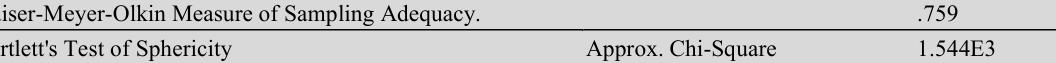
Exhibiting the KMO and Bartlett's Test Kaiser-Meyer-Olkin Measure of Sampling Adequacy.